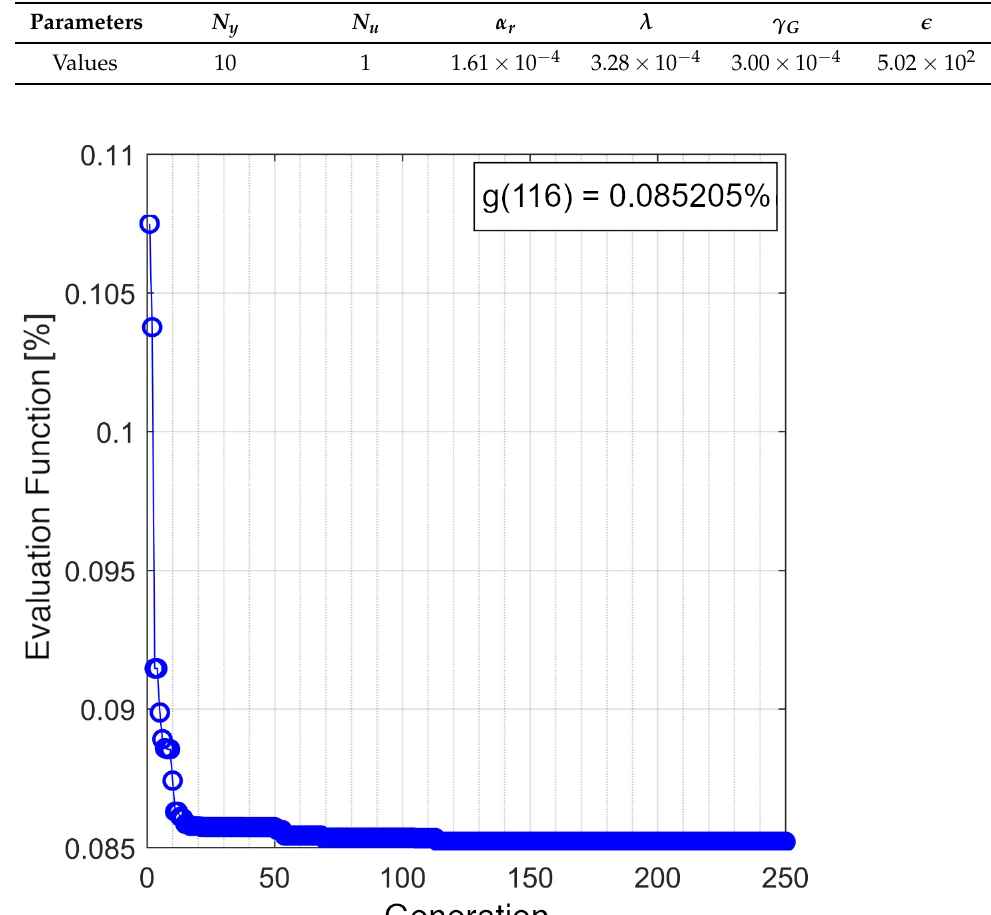
Table 4. Optimized parameters for the Practical Nonlinear Predictive Controller.